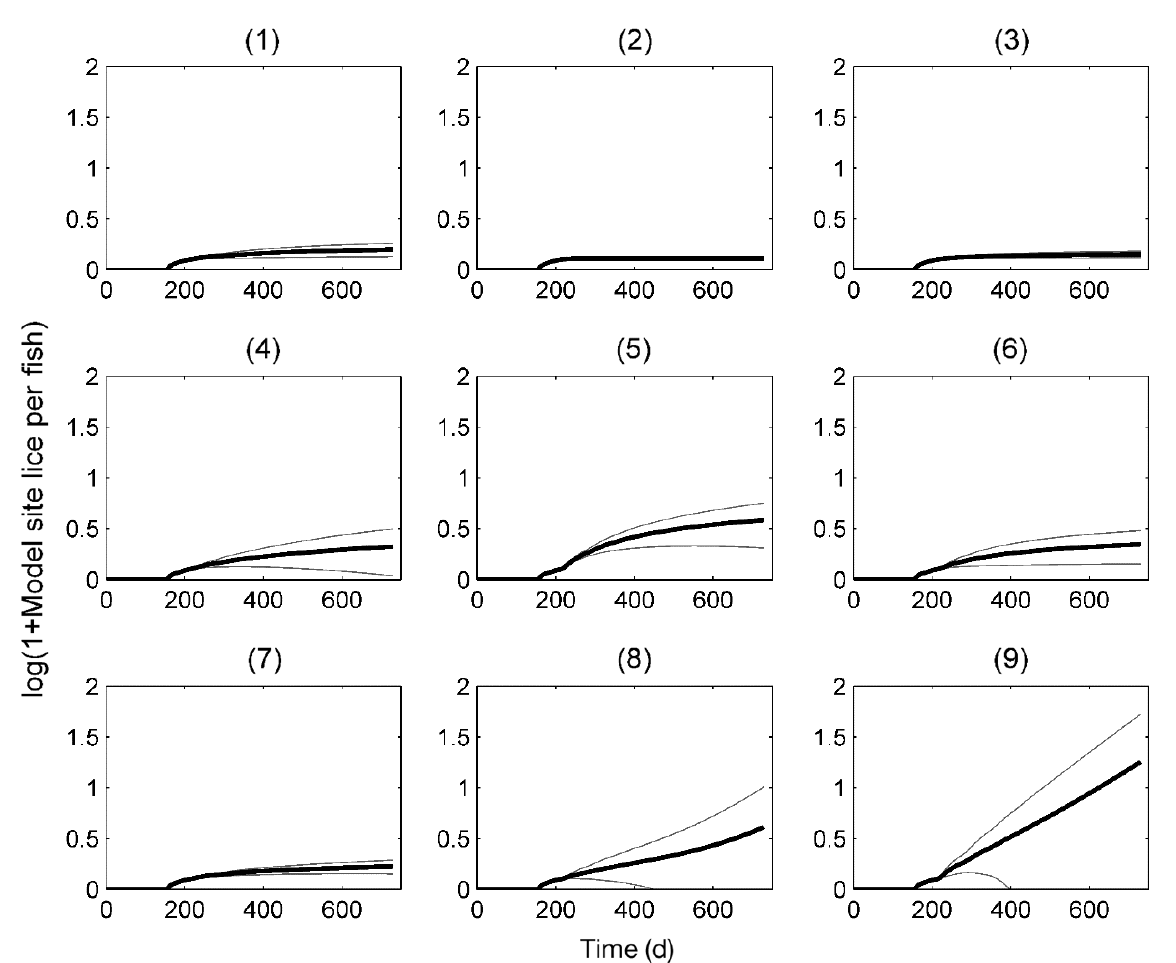
Fig. 3. Mean lice density (thick black line) and standard deviation over 100 runs (grey lines) of lice at each site (1 to 9), plotted over the duration of a production cycle, assuming a constant external infection of 0.01 lice fish −1 d −1 , reproduction of 5 lice adult female −1 d −1 at all sites, and no lice reduction management events. Numbers do not increase exponentially at all sites. Rather, they may reach a plateau where mortality and infection (which, due to connectivity, is different for each site) are in bal- ance. At approximately realistic parameter values, dynamics are governed by on-farm reproduction, meaning that